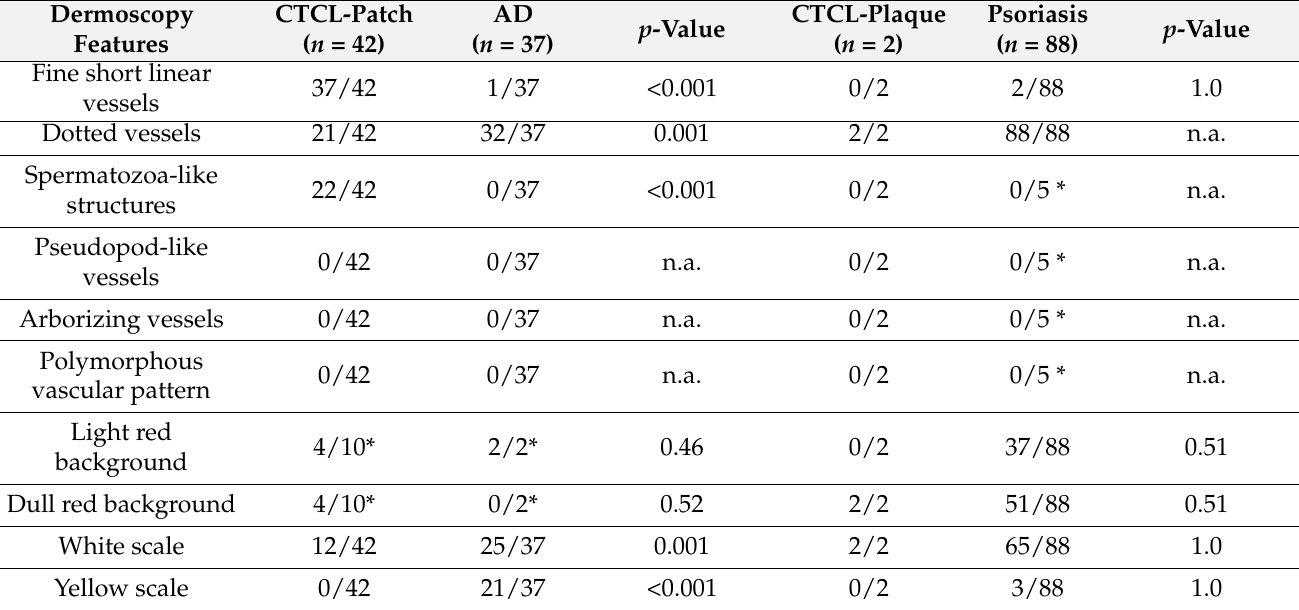
Table 2. A comparison of dermoscopy features seen in CTCL and atopic dermatitis (AD) and psoriasis patients.